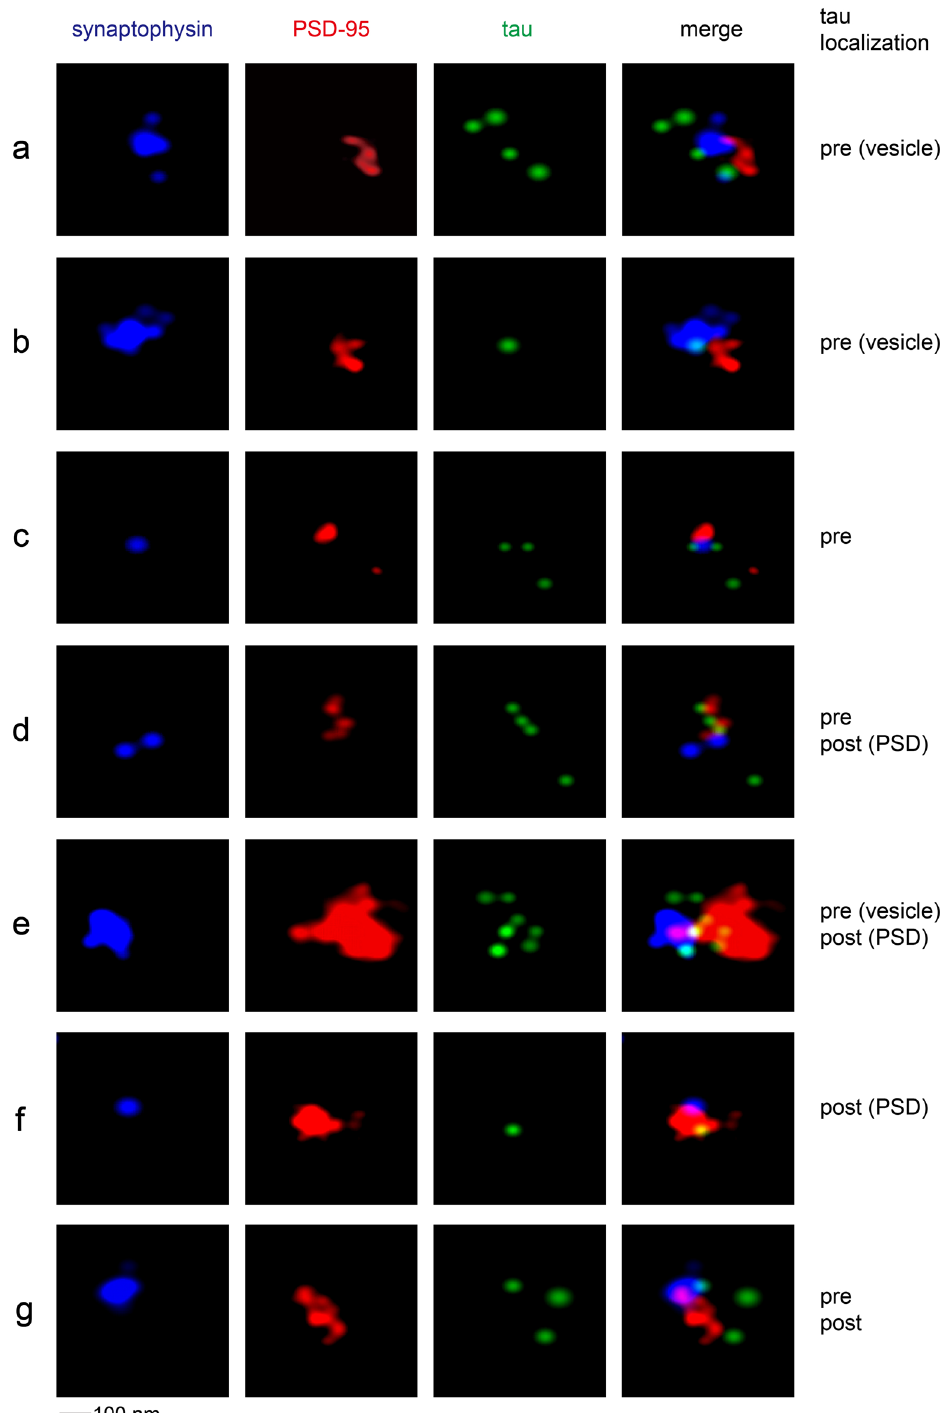
Figure 5. Three-channel dSTORM immunofluorescence imaging of cortical synaptosomes, against synaptophysin, PSD-95, and tau. Examples of bipartite synapses with different tau localization patterns are